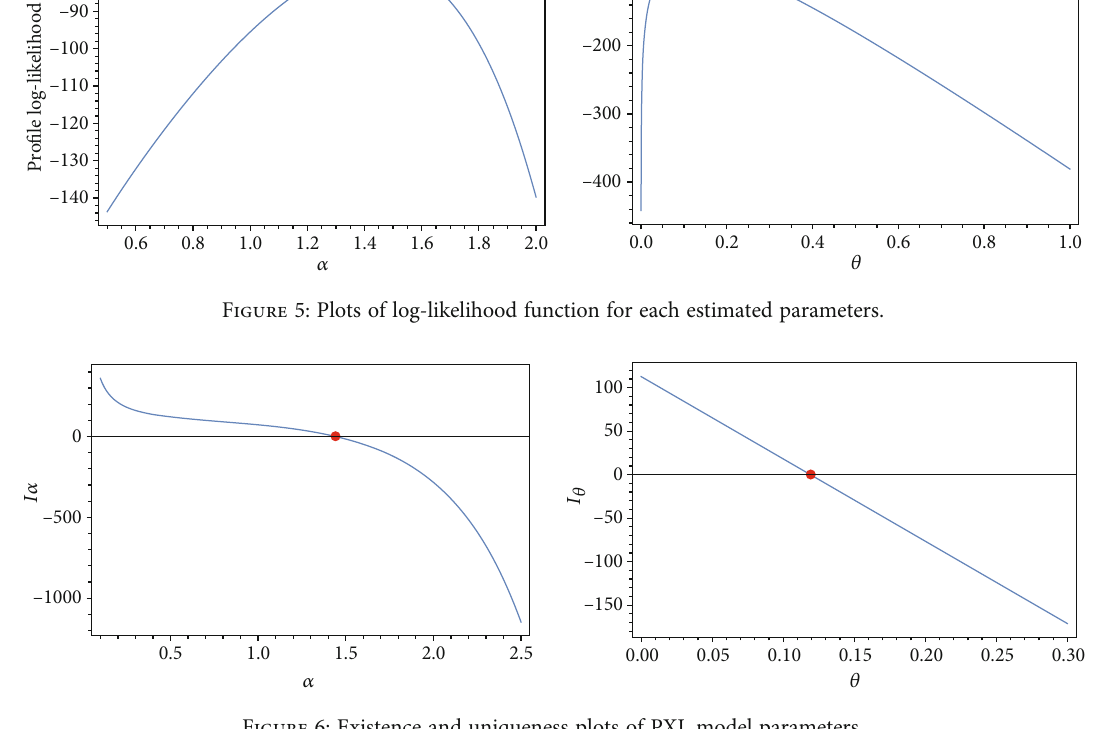
Figure 6: Existence and uniqueness plots of PXL model parameters.